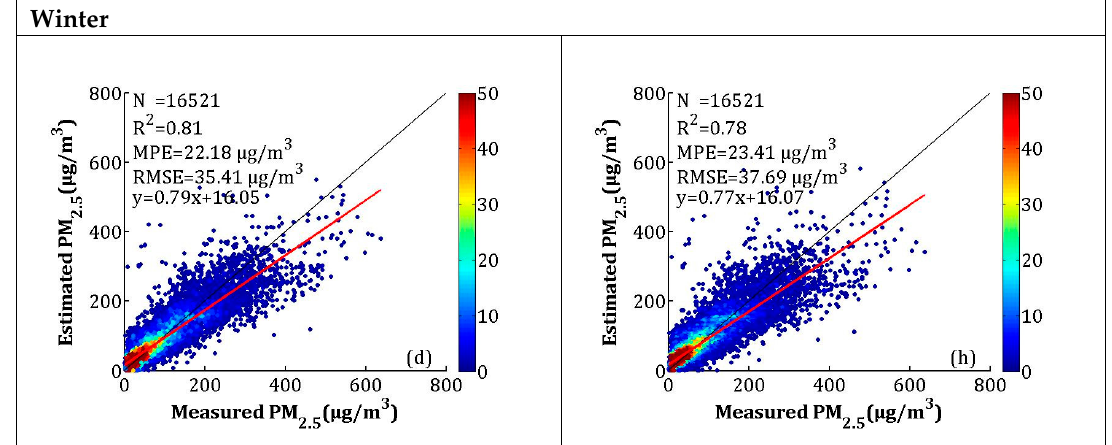
Figure 7. Scatterplots between the LME model fitting (cross-validation) and ground-measured PM 2.5 in each season: ( a – d ) the LME model fitting results, and ( e – h ) the cross-validation results. The dark solid line represents the 1:1 line, and the red solid line represents the regression line.